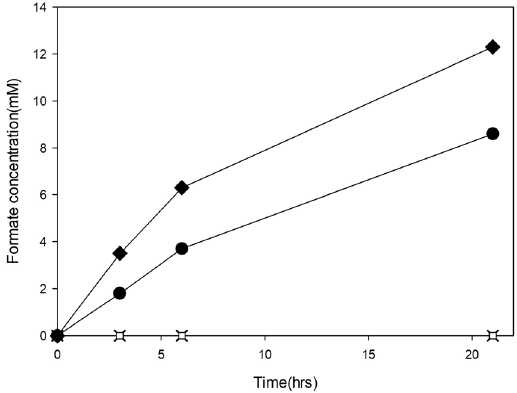
Figure 2. Formate production of strains in the electrochemical reaction system: F1A-P1 ( ⬥ ), WT ( ● ), F1A (X), F1AB-P1B ( □ ), reaction conditions: 0.6 g wet-cell, 10 mM MV, pH 6.0; CO 2 gas purging (99.999%, rate: 1 mL/s).